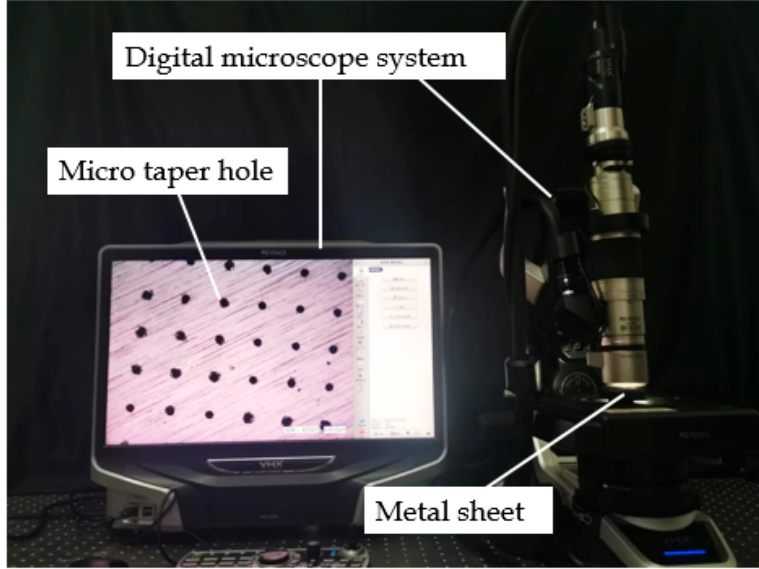
Figure 6. A photograph of the measurement setup of the micropore diameter. In this experiment, the large diameter of each metal sheet was measured under 1000 × focusing conditions with the ultra-depth-of-field microscope, and the small diam- eter was measured under 2000 × focusing conditions. During the laser drilling process, the large diameter X Sl and small diameter X ss of the laser machine were set as 20 µ m and 6 µ m, respectively. The nominal machining variance of this device was 3.2 µ m for the large diameter and 0.10 µ m for the small diameter. According to Equation (20), the theoretical diameter distribution curve of this laser machine could be obtained, which served as the machined standard value in this study. In Figures 7 and 8, the green curve denotes the machined standard values of the large diameter and the small diameter, respectively; the red and purplish red histograms represent the experimentally measured data of the large diameter and the small diameter, respectively; and the red curve represents the fitted normal distribution curve.